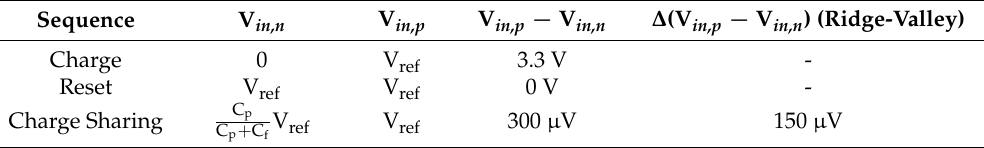
Table 4. The value of V in,n and V in,p during the data-processing sequence.